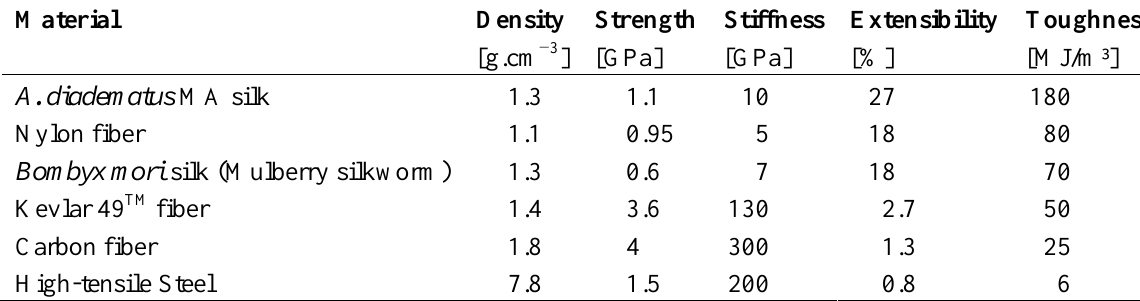
Table 2. Comparison of the mechanical properties of A. diadematus MA silk fibers and other natural and synthetic fibers (data taken from [6,29]).